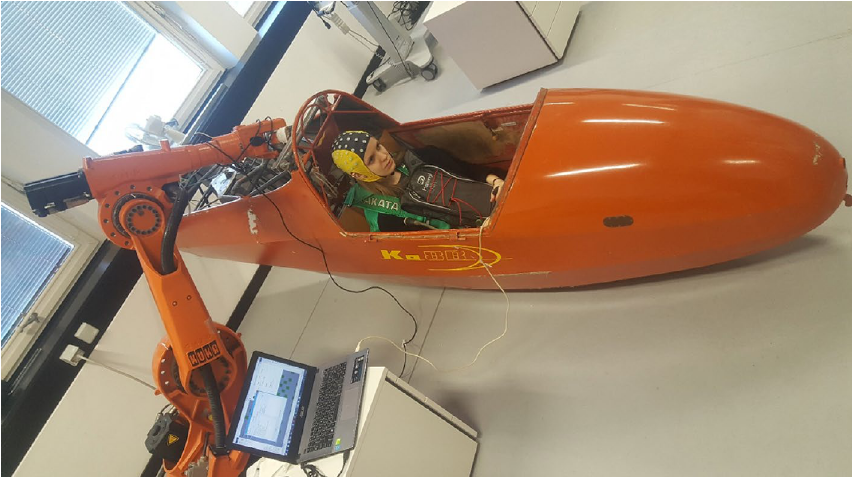
Figure 1. Experimental setup. The KUKA robot was connected to the glider and tilted in the left and right directions at angles of 1.5°, 5° and 10°. The participant fastened a seatbelt to reduce the movements during the experiment. Additionally, the participant kept a bag in front of her in which the EEG amplifier was placed to have the connection with the EEG cap. The participant visible in this figure gave informed consent to publish this figure in an open access